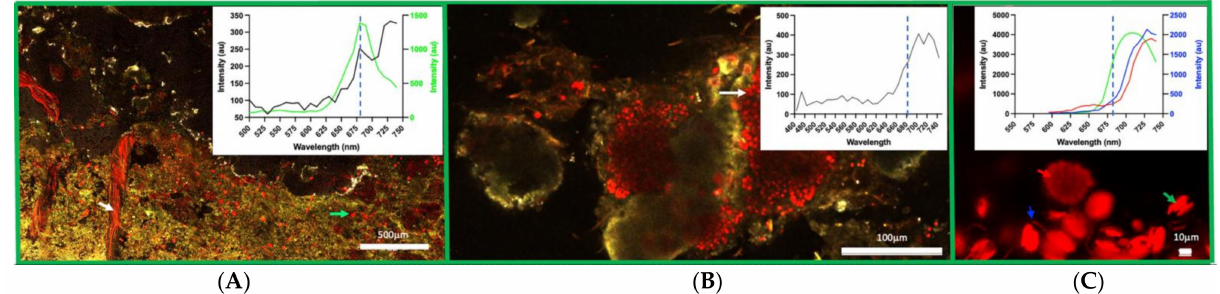
Figure 2. Confocal Imaging of the green layer. A side view of an excised segment randomly sampled from a smooth mat at Nilemah. For reference, the blue dotted line at 680 nm shows a typical Chl a emission. ( A ) A large section (1 cm × 0.6 cm) of the green layer imaged by hyperspectral confocal microscopy using a 458 nm laser with 10 nm continuous band pass emissions collected up to 750 nm. The red organisms consist of red and far red/NIR (700–750 nm) fluorescing pigments. Both filamentous and coccoid forms are observed. The filamentous forms (white arrow) contain a far-red emitting (750 nm peak) pigment that is most likely Chl f . The green arrow shows coccoid cells exhibiting a Chl a emission profile. Scale bar 500 µ m. ( B ) Emission spectra of typical clusters of coccoid cells (white arrow) when excited by the 458 nm laser. Two peaks are evident at 704 nm and 724 nm, suggestive of the presence of Chl d (724 nm). Scale bar 100 µ m. ( C ) The arrow shows the various microbial forms that were found in the initial NIR enrichment culture. The green arrow shows a diatom (emission peak 710 nm), the blue arrow shows a filamentous form (emission peak 730 nm) and the red arrow shows a cluster of coccoid cells (emission peak 730 nm). Scale bar 10 µ